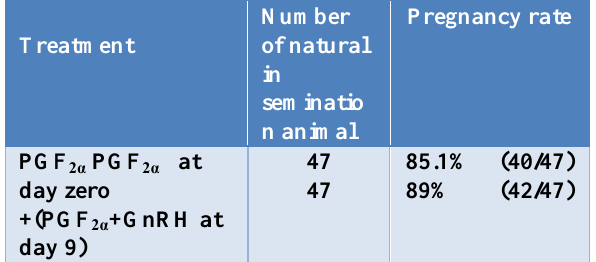
Table, 1:Efficiency of different protocols on pregnancy rate in postpartum anoestrus buffaloes (persistent corpus